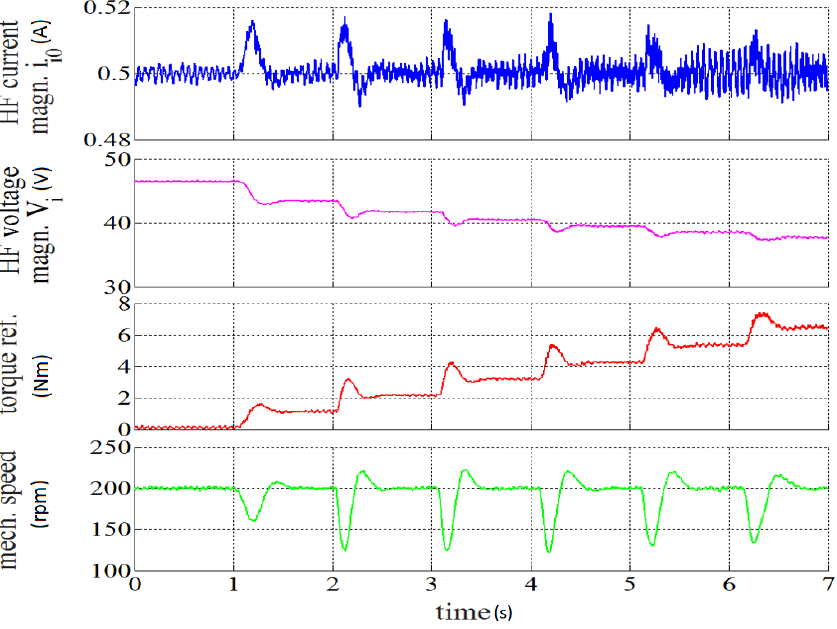
Figure 17. Motor#2: Sensorless speed control (MTPA), gain adaptation and i i 0 regulation, 200 rpm, 1-Nm steps from 0 to 6 Nm.